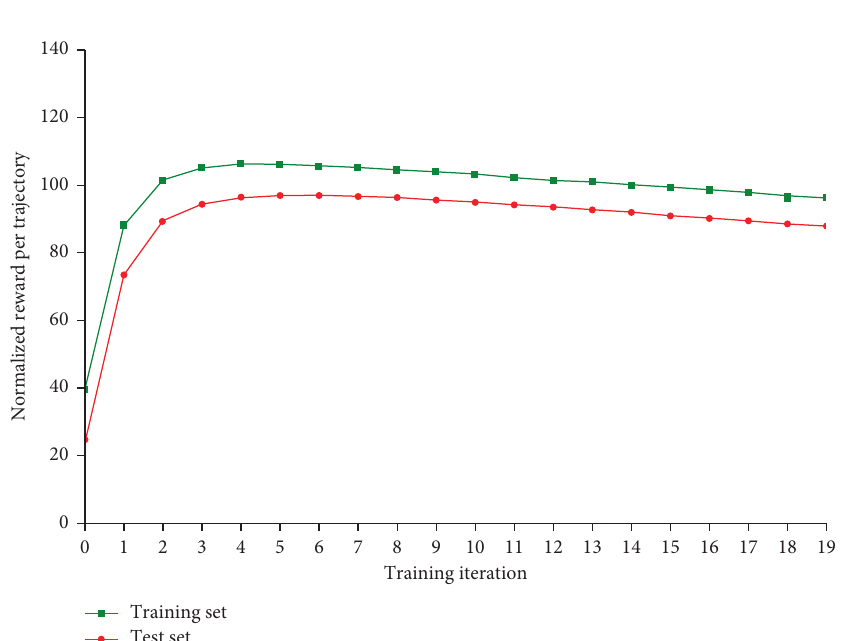
Figure 6: The change of RMSPE of spacing during training.